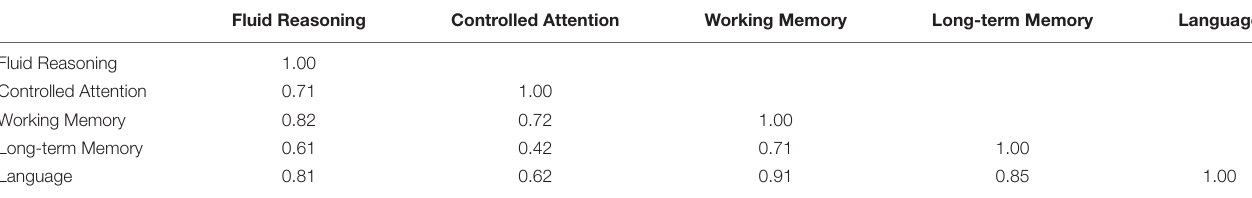
TABLE 3 | Correlations among latent variables for the two groups combined (all correlations significant at p <